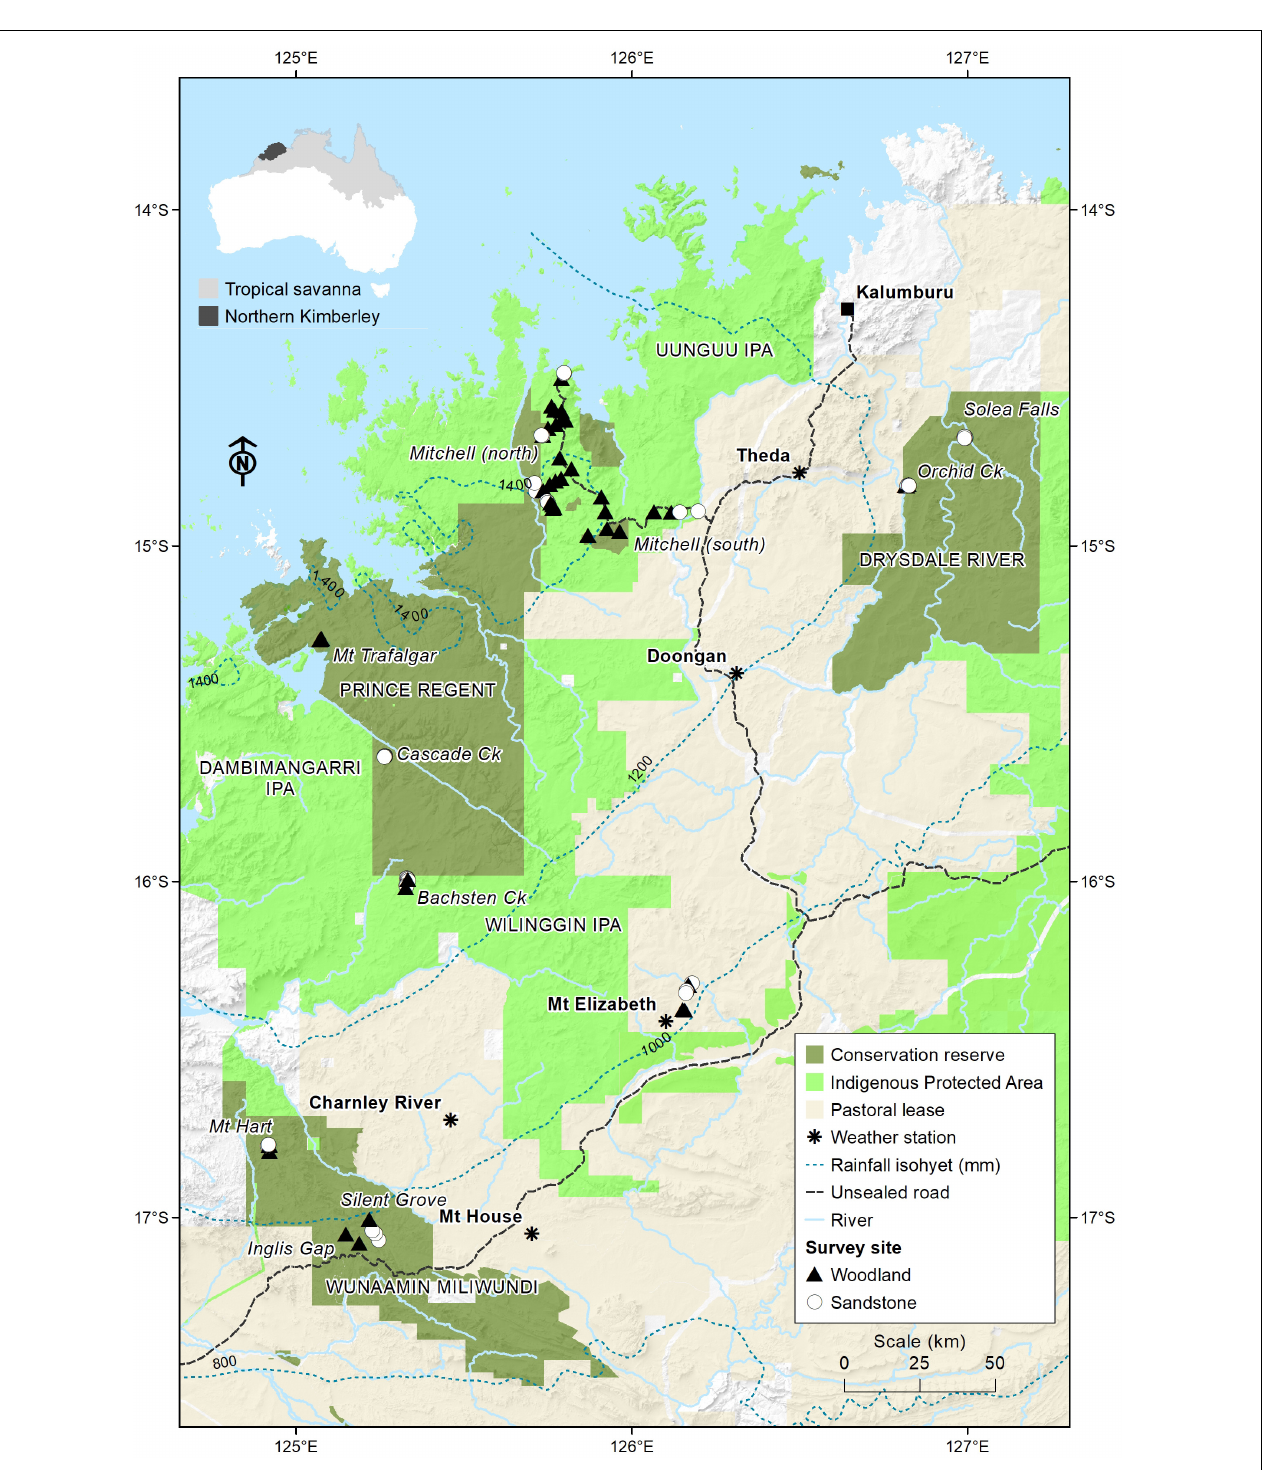
FIGURE 1 | Locations of survey sites and locations in the Northern Kimberley region of northern Western Australia.